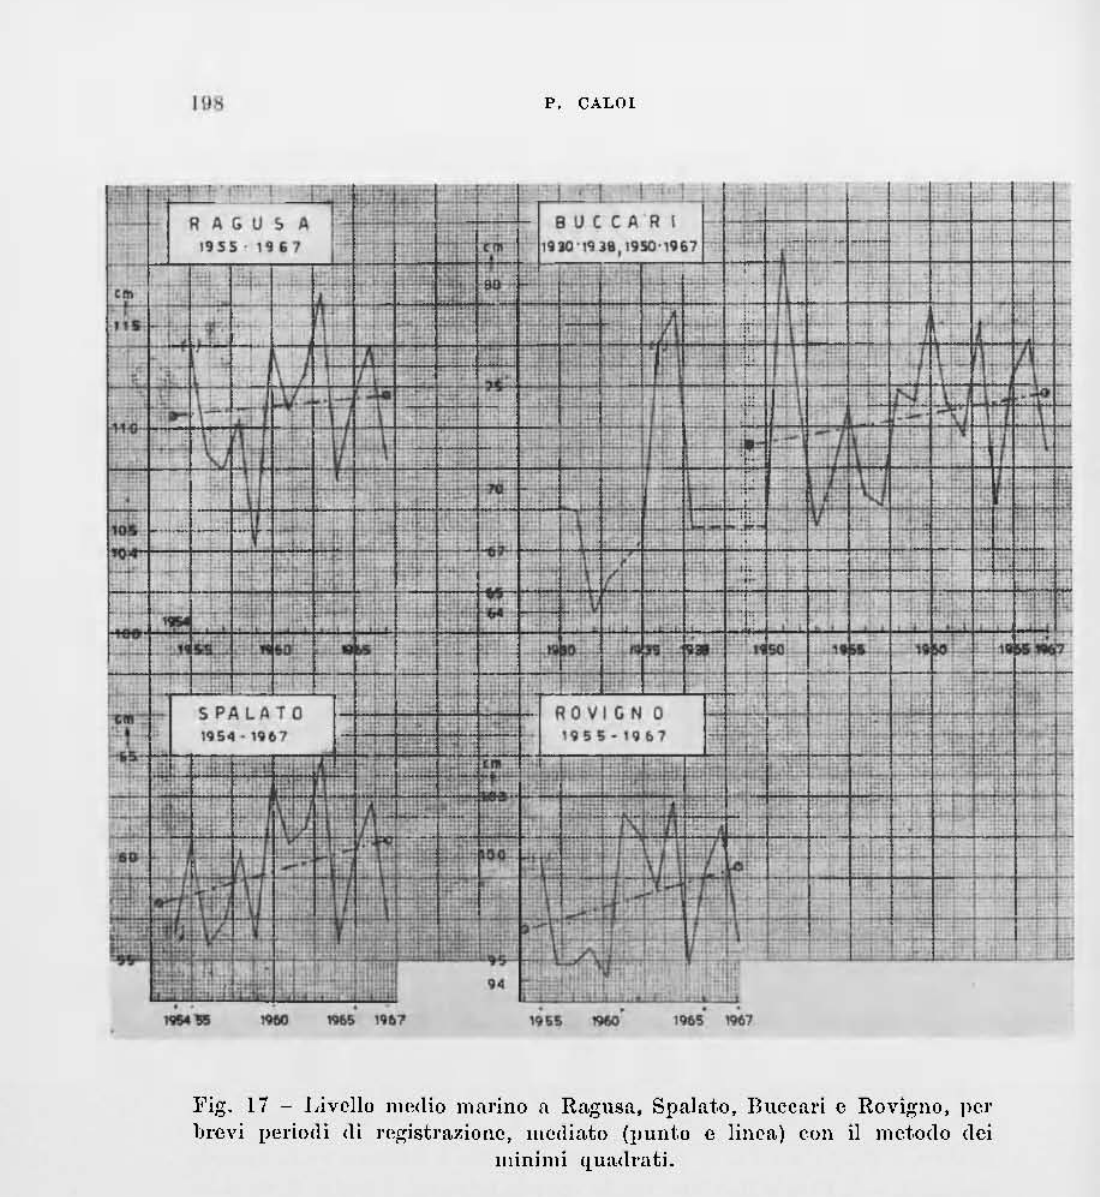
Fig. I i - ~!{'an l!pa lcycls oi Ragusa, Spalato, lluccnri and Rovigno,